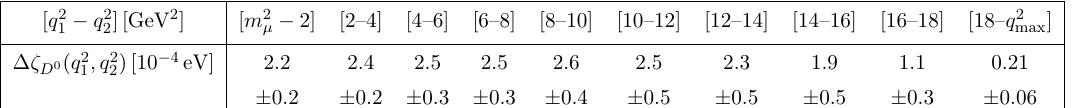
Table 9 . Distribution of (cid:1) (cid:16)